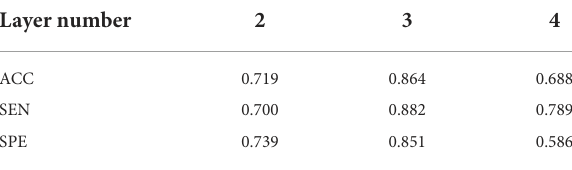
TABLE 1 Classification performance of different number of graph convolutional